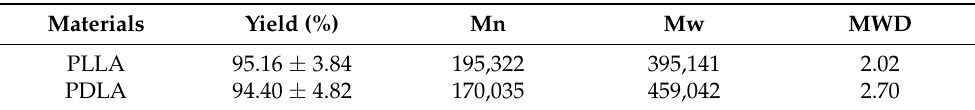
Table 1. PLA homopolymer synthesis through bulk ring-opening polymerization of lactide at 130 ◦ C with reaction time 24 h.